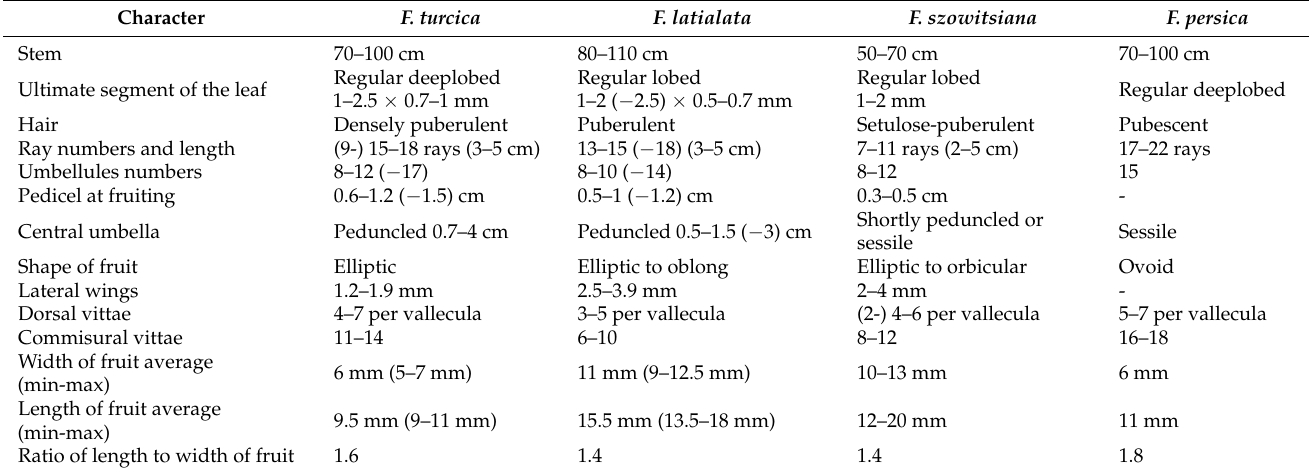
Table 1. Comparison of the diagnostic characters of Ferula turcica , F. latialata, F. szowitsiana, and F. persica